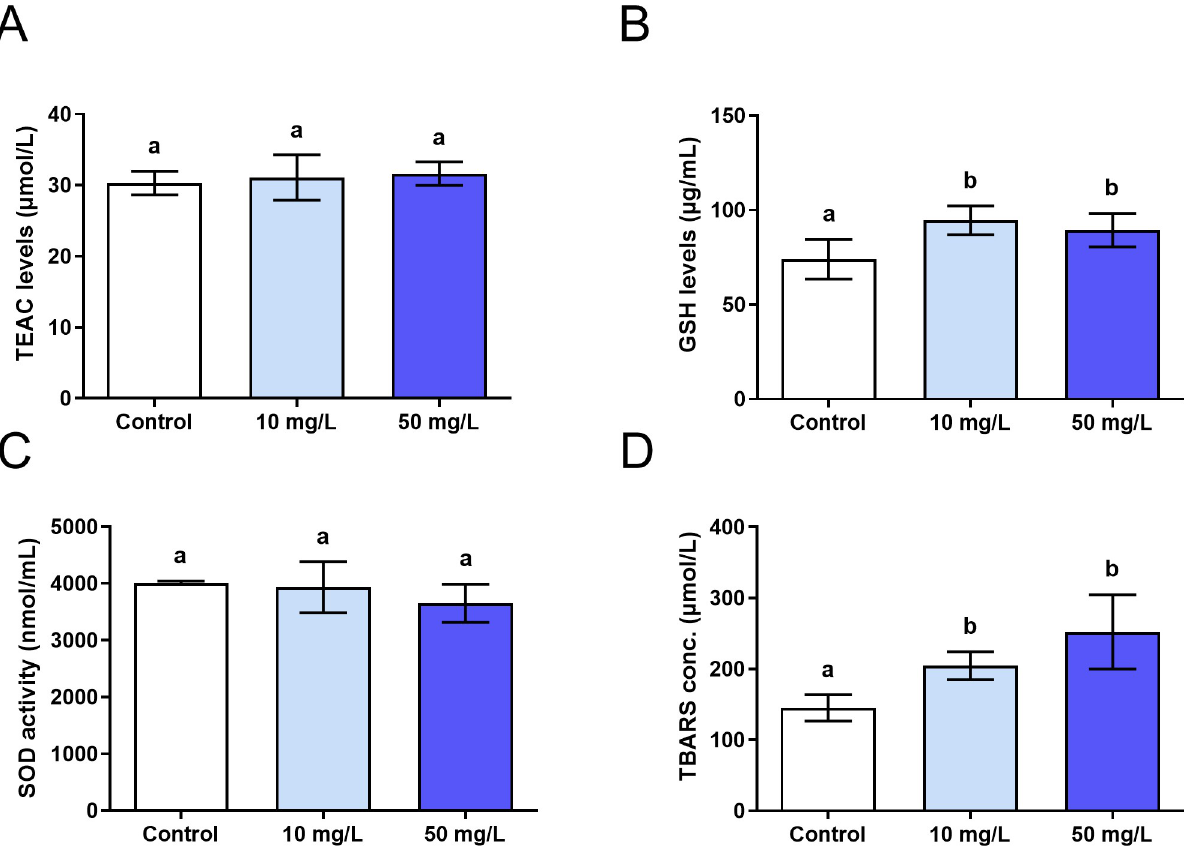
Fig 3. Oxidative biochemistry assessment. Analysis of oxidative biochemistry in the parotid glands of mice (n = 30, 10 per group) exposed for 60 days to 0 mg/L, 10 mg/L and 50 mg/L of fluoride (F). Results are expressed as mean ± standard deviation of the values referring to the oxidative parameters: A) TEAC levels; B) GSH levels; C) SOD activity; D) TBARS concentration. The different letters on the columns indicate significant differences among the groups according to One-way ANOVA test, with Tukey posttest, p < 0.05.